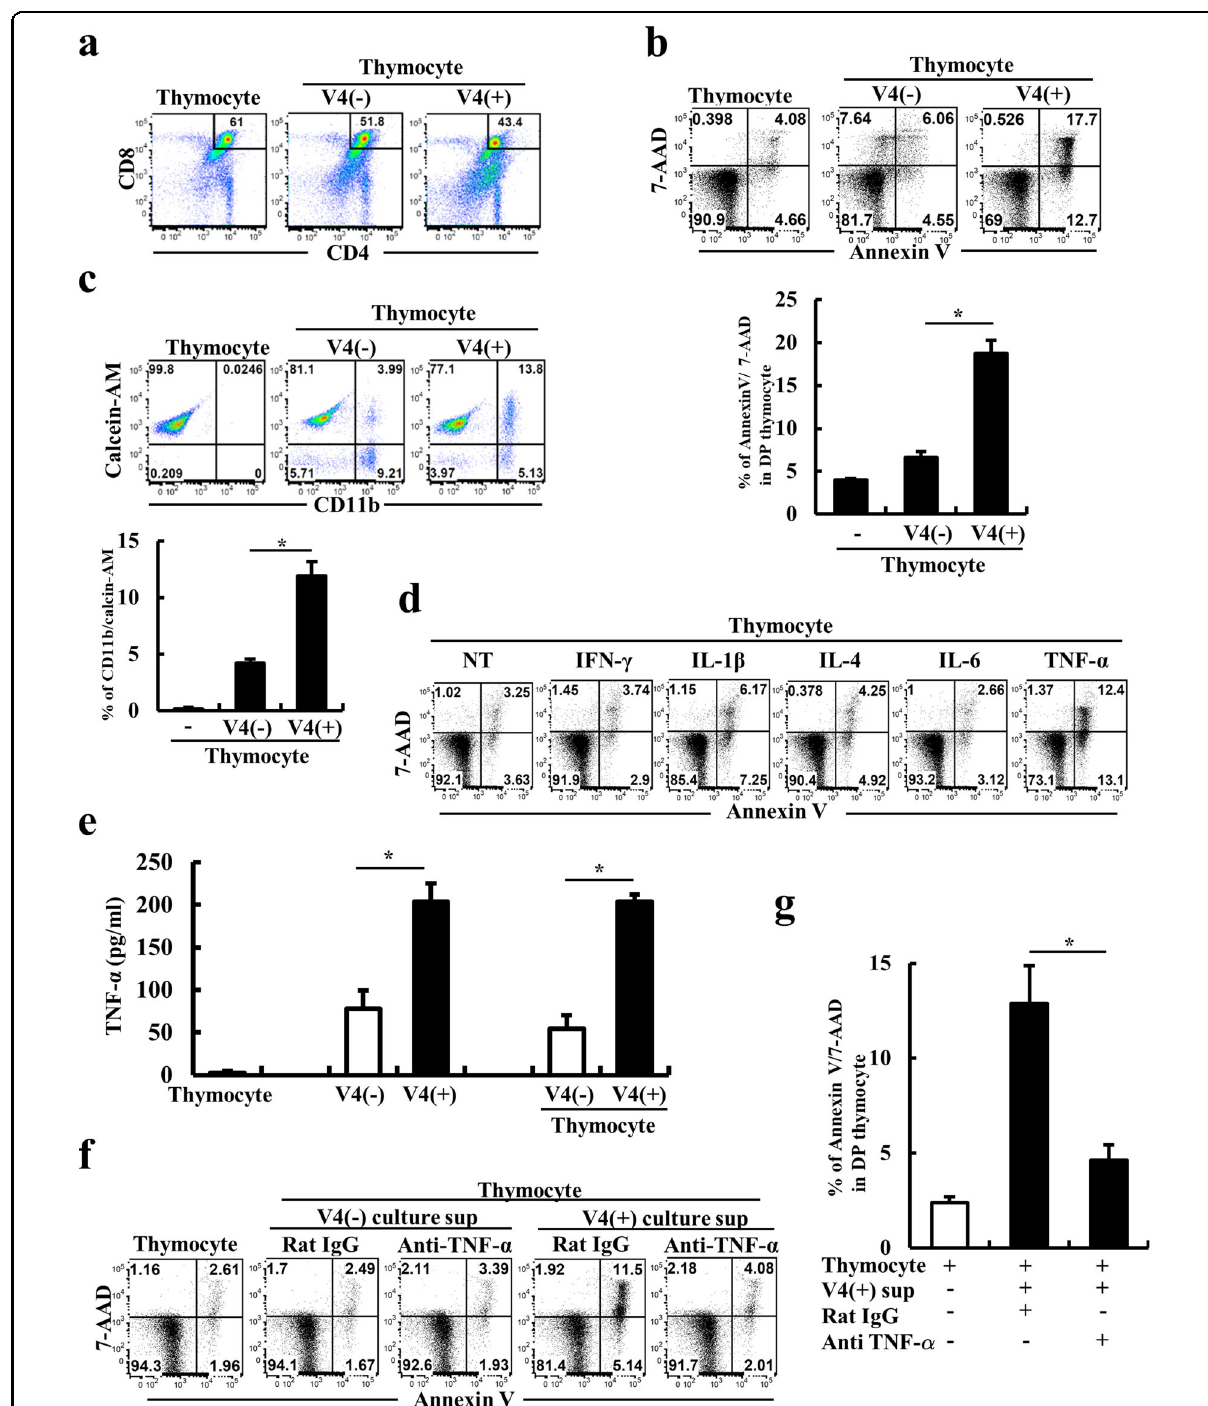
Fig. 5 (See legend on next